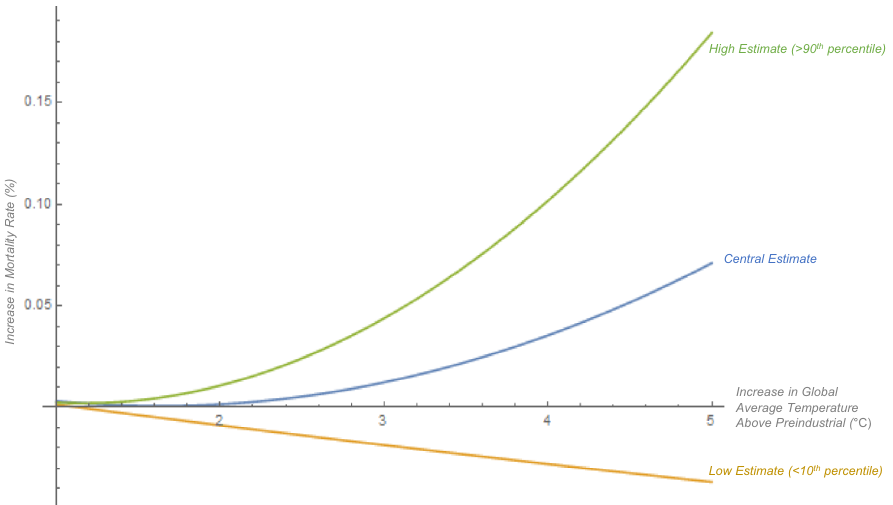
T β T 2 where T t þ t t is the 1 2